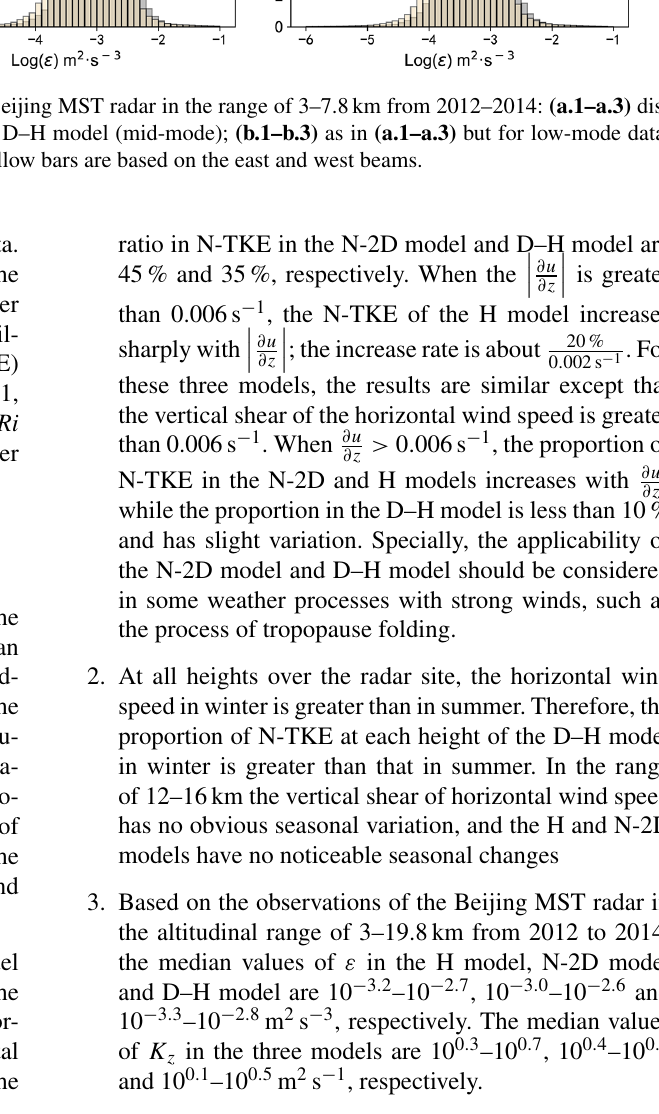
in turbulence parameters calculated by different radar